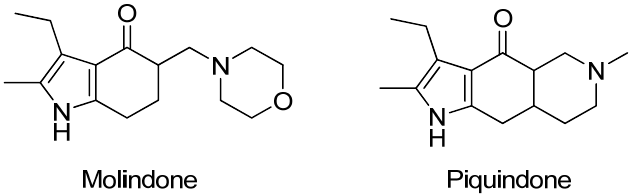
Figure 1 . The structure of molindone and piquindone . Figure 1. The structure of molindone and